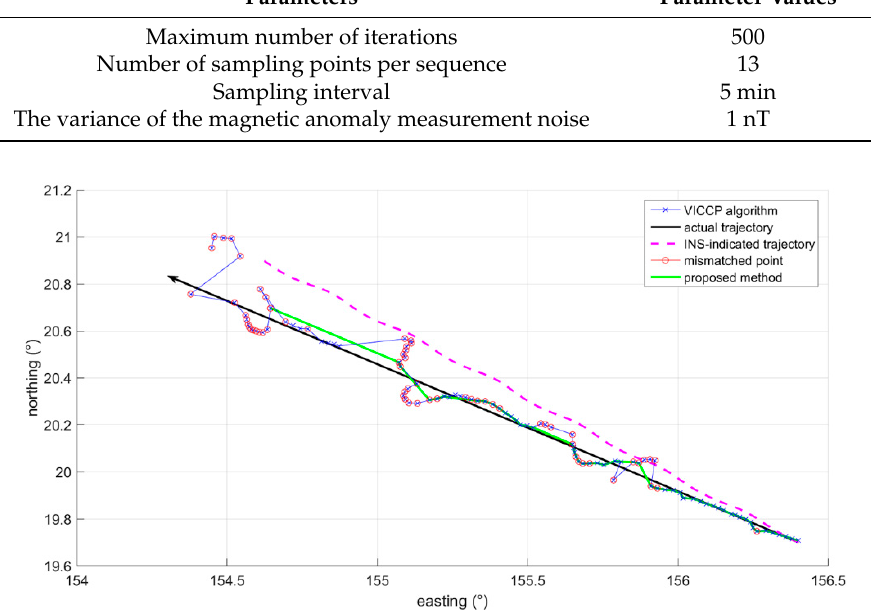
Figure 4. Matching results within nine hours.